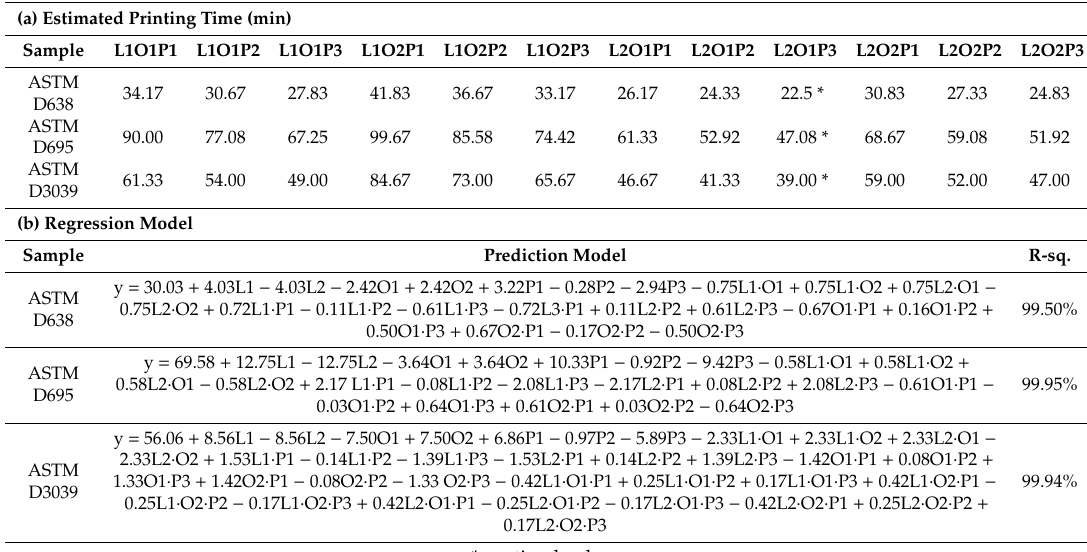
Table 7. Estimated printing time of each parameter combination and the fitted regression